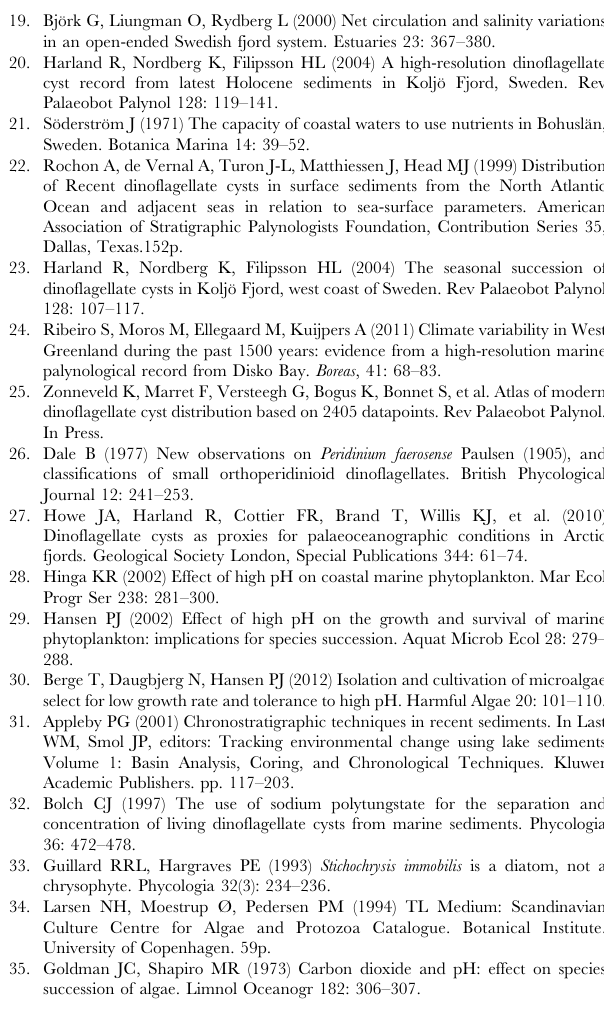
Table S1 Upper pH tolerance limits for growth for the 18 Pentapharsodinium dalei strains at salinity 15 and